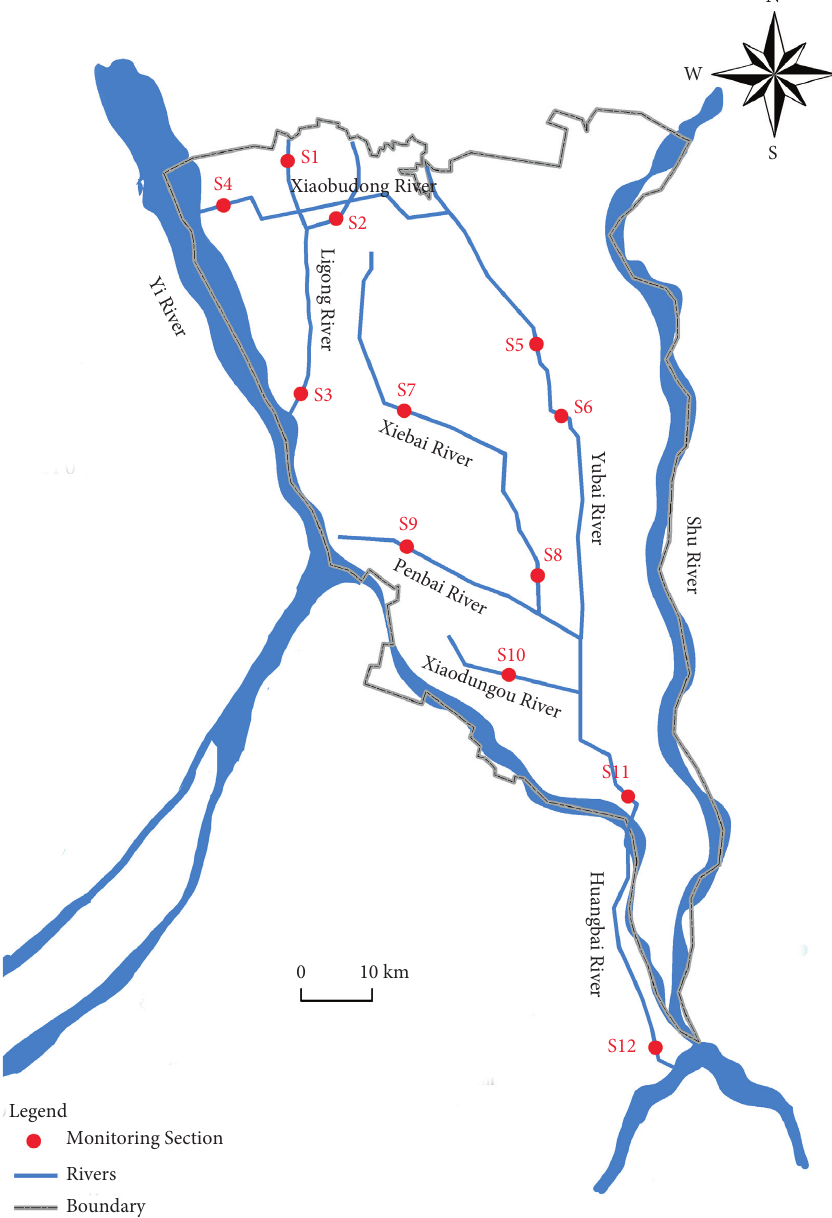
Figure 3: Distribution of monitoring sections in the study